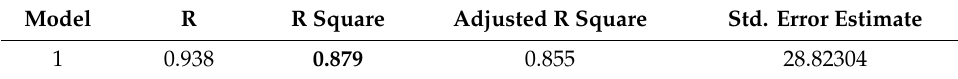
Table 2. The result of Multiple Regression Analysis for six parameters from the Global Fuels category. Model R